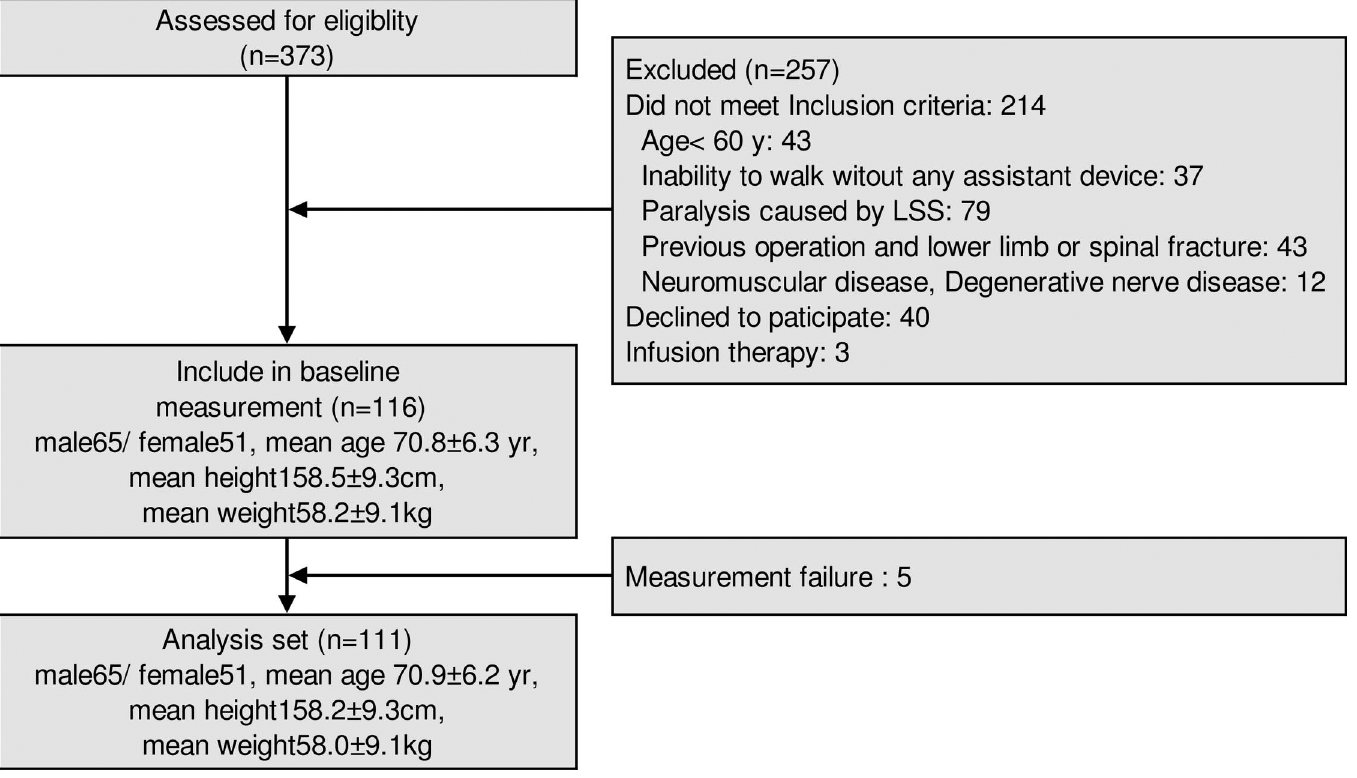
and knee flexion angle, maximum hip and knee extension angle, maximum hip flexion and ankle dorsi flexion moment, and minimum hip power were all significantly correlated with the maximum trunk flexion angle. In our stepwise multiple linear regression analysis with maxi- ance was as follows.